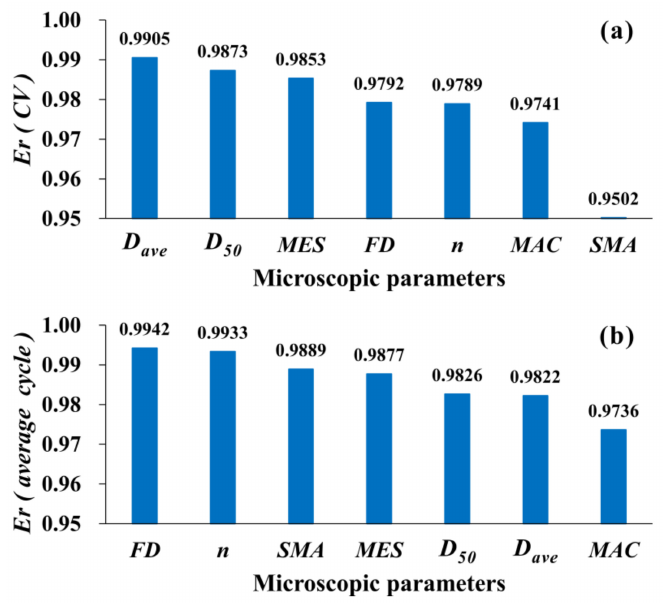
Figure 19. ( a ) Contribution of different micro parameters to coefficient of variation; ( b ) contribution of different micro parameters to average cycle time.